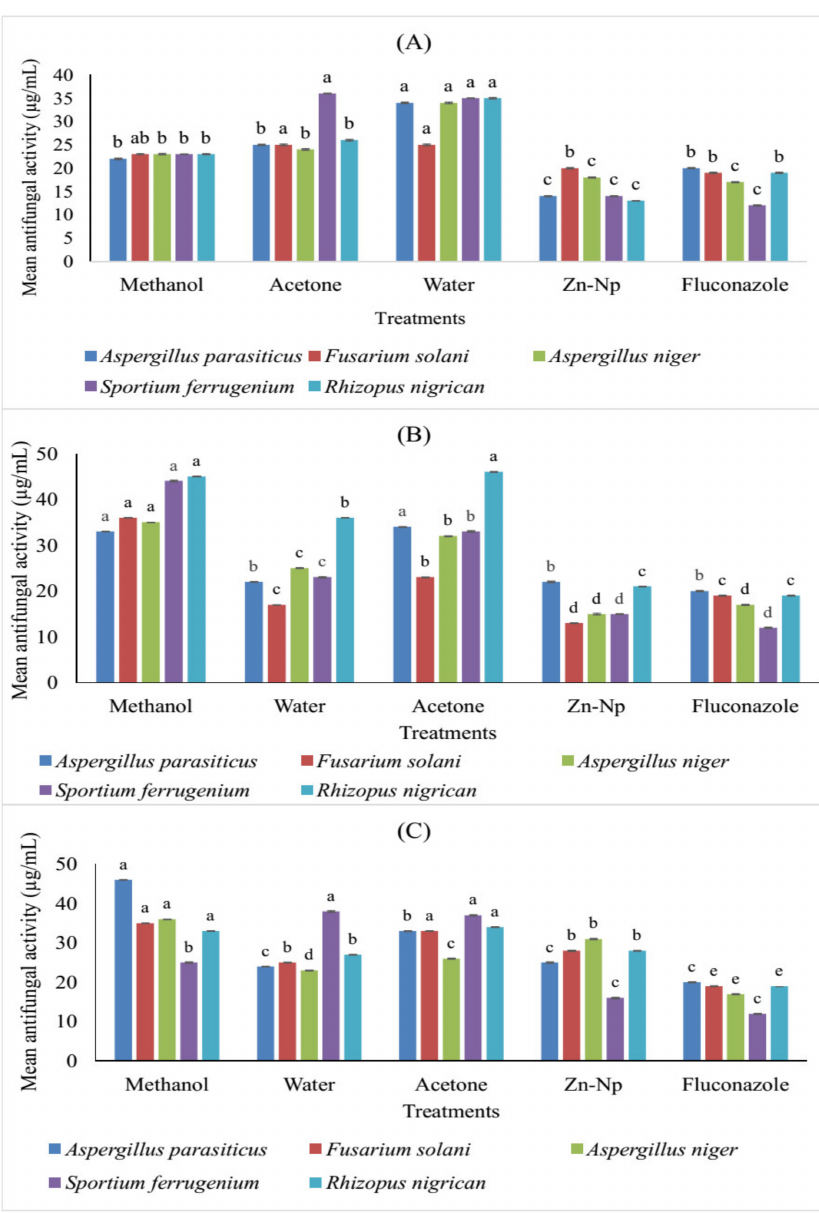
Figure 7. Comparison (MICs) in ( µ g/mL) different concentrations offlower ( A ), leaf ( B ), and stem ( C ) extracts of C. gigantea along with nanoparticles against selected fungal strains. Bars with different letters are significantly different from each other at p = 0.05